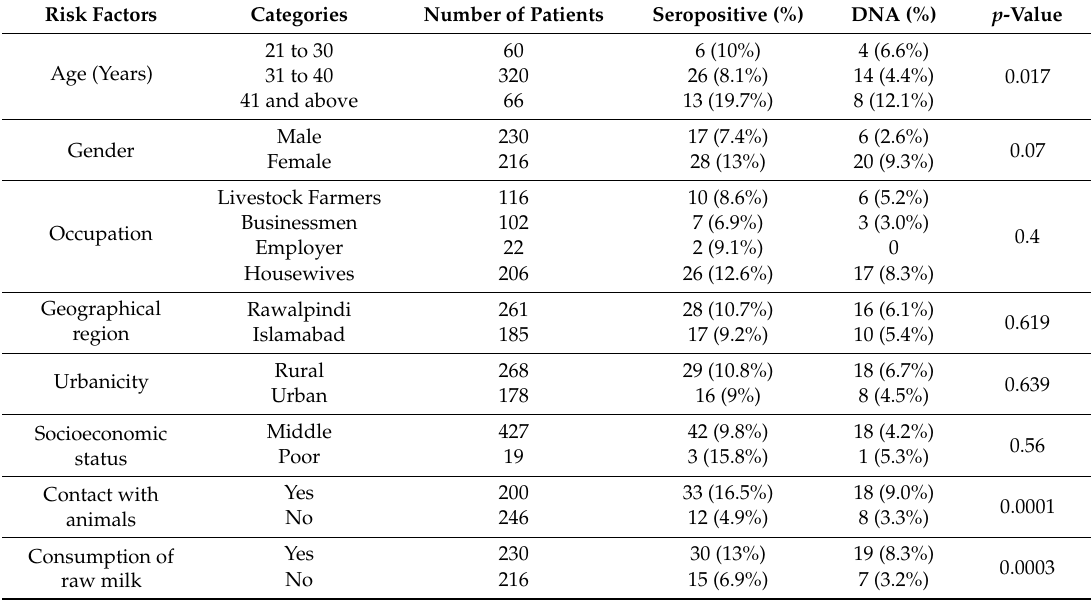
Table 3. Detection of anti- Brucella antibodies and DNA in AFI patients using RBPT and real-time PCR, respectively, in three tertiary care hospitals of the Rawalpindi / Islamabad region, Pakistan, according to their potential risk